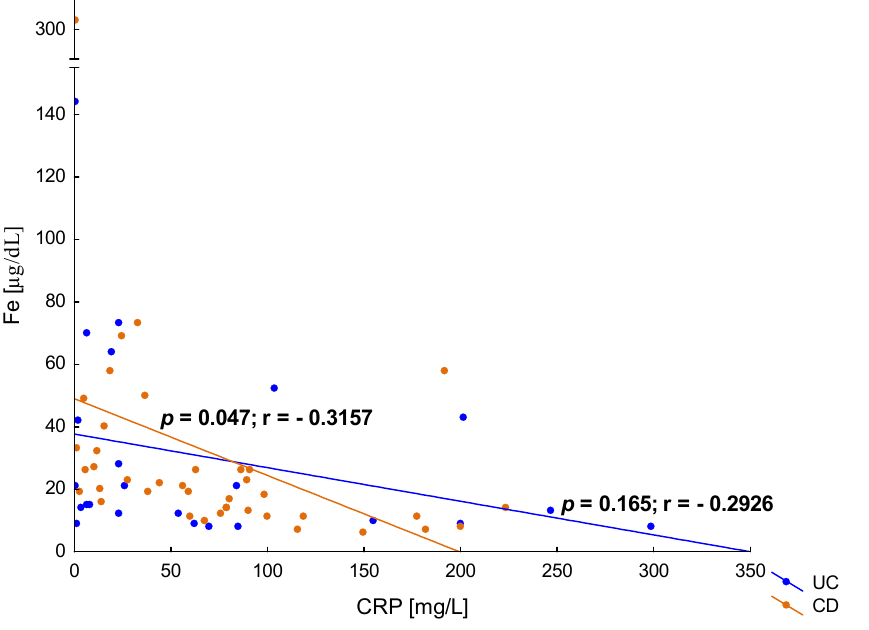
Figure 6. The correlation between iron (Fe) and C-reactive protein (CRP) concentration in patients with ulcerative colitis (UC) and Crohn’s disease (CD).